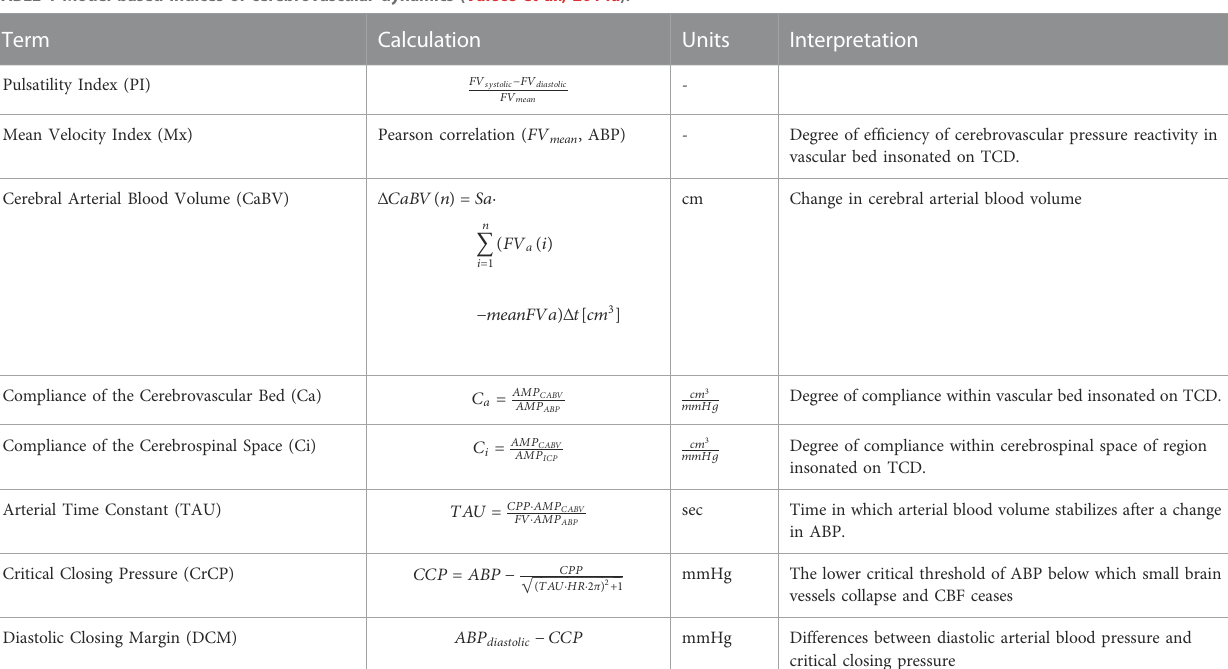
TABLE 1 Model based indices of cerebrovascular dynamics (Varsos et al.,